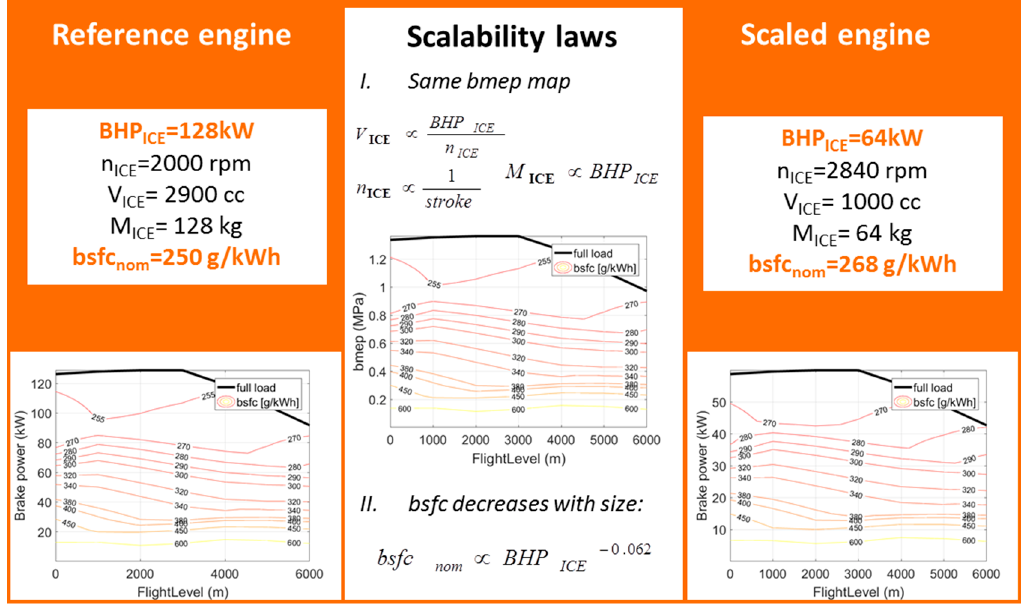
Figure 10. The scalable engine model (BHP ICE : engine brake horse power, n ICE : engine rev/min, V ICE : engine displacement, M ICE : engine mass, bsfc: brake-specific fuel consumption).